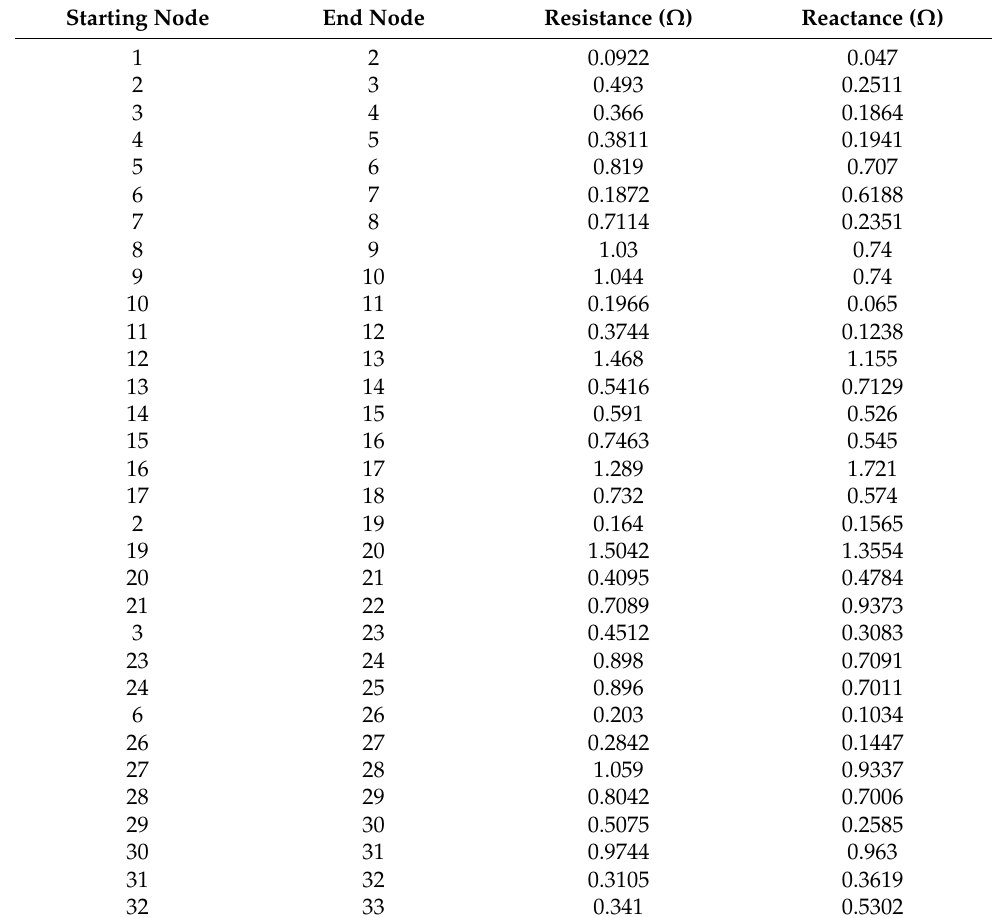
Table A2. Line parameters of IEEE-33 node power distribution